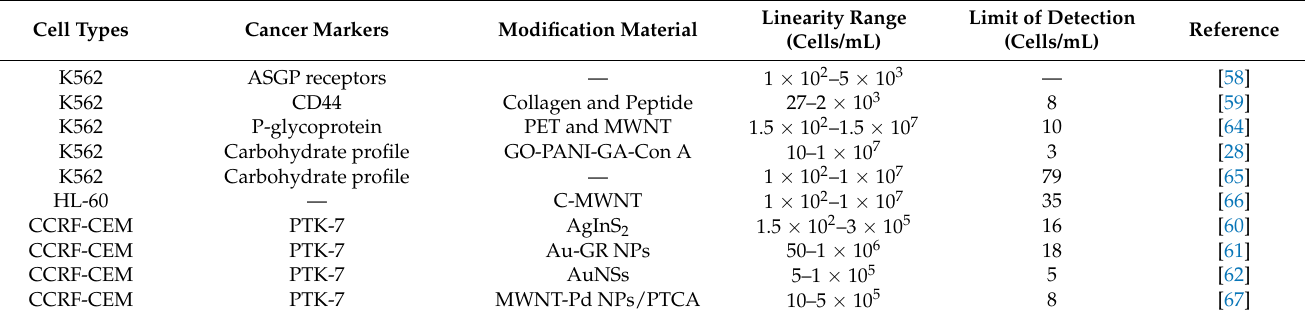
Table 5. Electrochemical cytosensors used for leukemia cell detection.